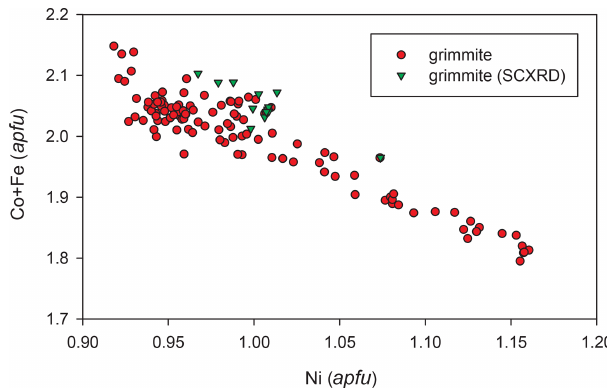
Figure 4. The Ni vs. Co + Fe (apfu) graph for all studied grimmite grains from Pˇríbram; SCXRD – grain used for single-crystal study.